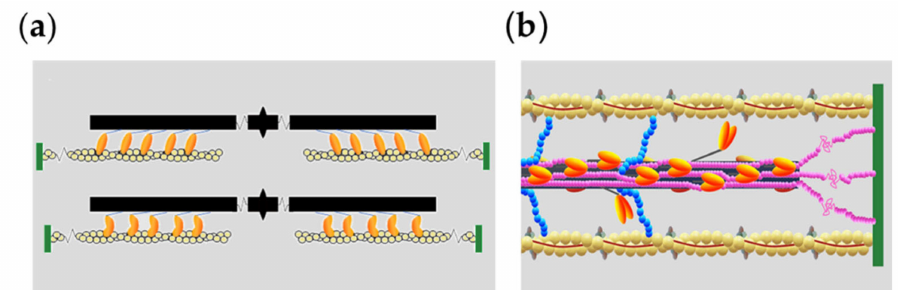
Figure 1. ( a ) Cartoon illustrating sarcomere shortening due to the reciprocal sliding between the myosin filament (black) originating from the center of the sarcomere (M line) and the actin filament (yellow) originating from the Z line at the end of the sarcomere (green), powered by the interdomain structural change in the S1 fragment of the myosin motor (orange) from the pre- (upper panel) to the post-working stroke conformation (lower panel). ( b ) Schematic representation of the half-sarcomere protein assembly at rest. Shown are actin (yellow), tropomyosin (Tm, red) and troponin complex (Tn, light and dark gray and brown) on the thin filament. On the thick filament (black), most of the S1 fragments of myosin dimers (orange) lie tilted back (OFF state) and the S1 fragments of two dimers move away with the tilting of their S2 rod-like domain (ON state); the MyBP-C (blue) lies on the thick filament with the C-terminus and extends to the thin filament with the N-terminus. Titin (pink) in the I-band connects the Z line to the tip of the thick filament and in the A-band runs on the surface of the thick filament up to the M line at the center of the